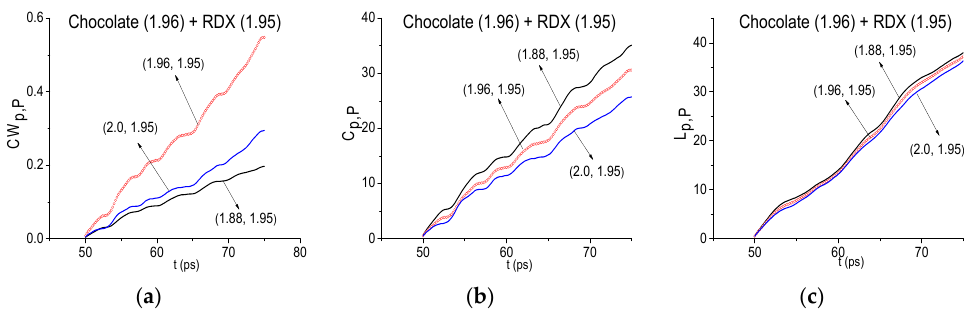
Figure 20. ICC’s CW p,P ( a ), C p,P ( b ), L p,P ( c ) calculated for frequency ν = 1.96 THz with the spectral resolution Δ ν = 0.04 THz for signal Chocolate and RDX_Air as a standard one.